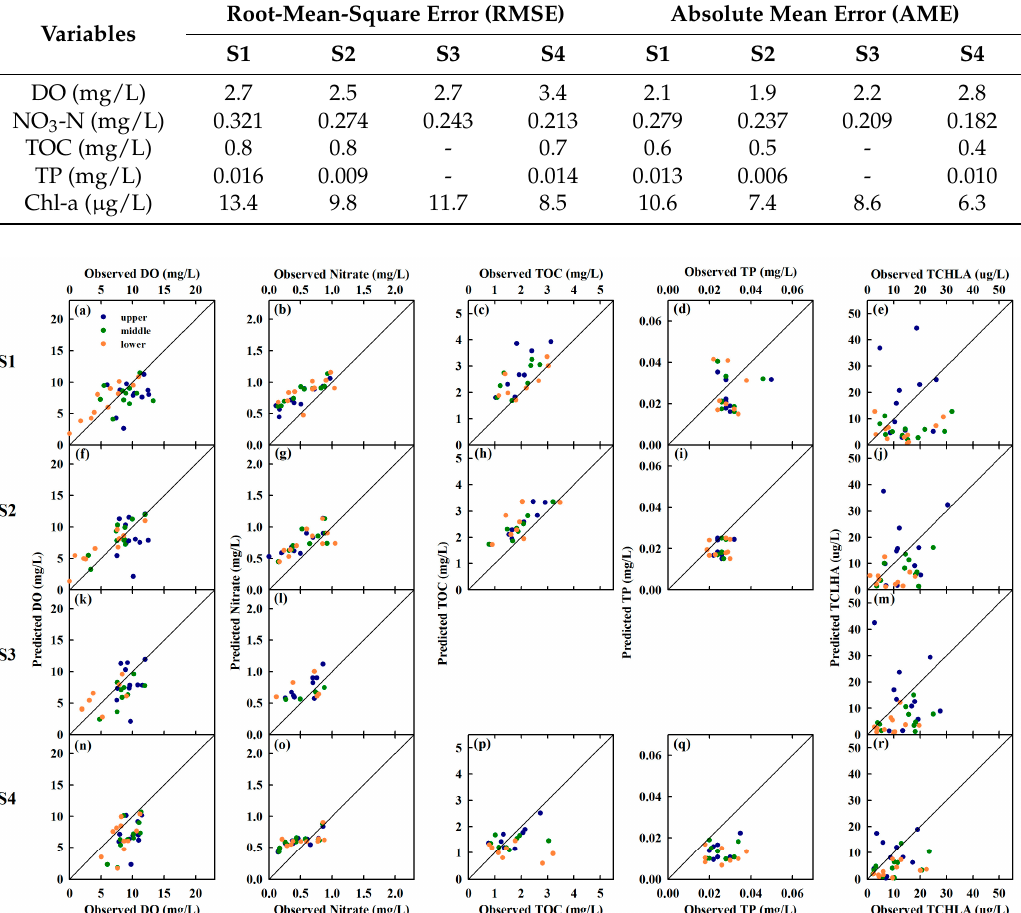
Table 4. Modeling errors for each point and water quality constituents in the Jinyang Reservoir. Variables